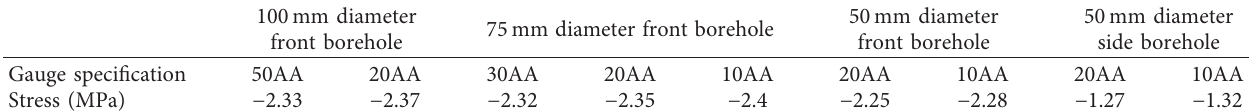
Figure 5: Influence range of boreholes with different diameters: (a) 100mm, (b) 75mm, and (c) Table 2: Stress data from boreholes of different diameters determined using different strain gauges.